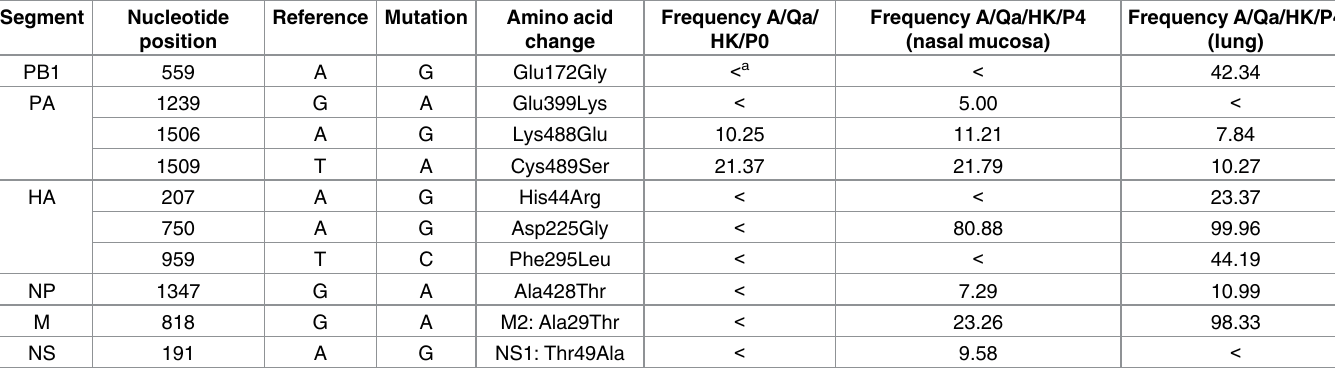
Table 3. Mutations present in parental and passage four H9N2 virus isolated from the nasal respiratory mucosa or from the lung. Segment Nucleotide